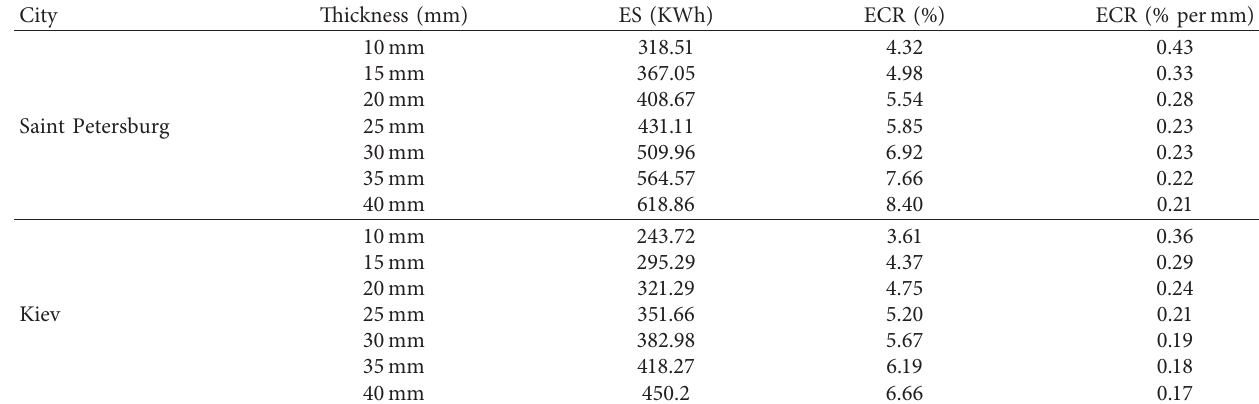
Table 3: Energy savings as a function of PCM thickness.